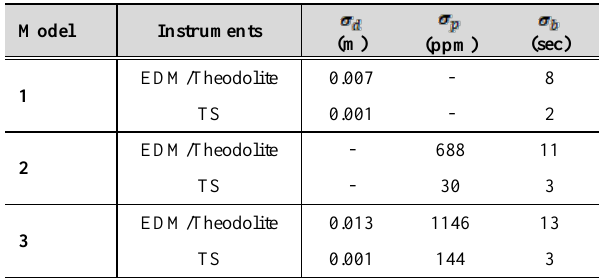
Table 2. Results of VCE for traverse network Dataset 1 using